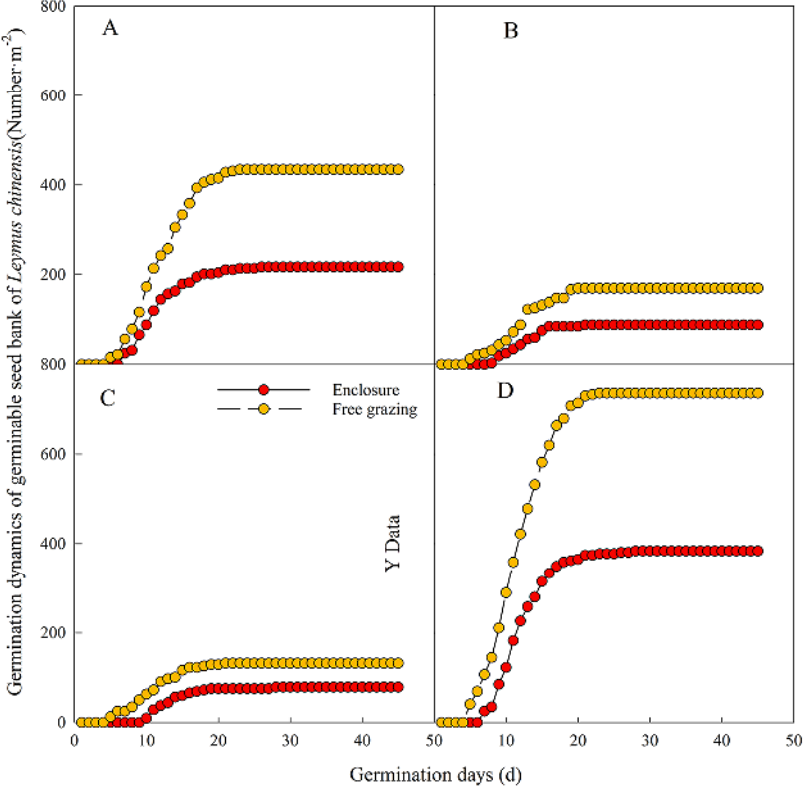
Figure 4. Dynamics of Leymus chinensis seed germination among the free-grazing and enclosed areas in the same soil layer. Note: Figures ( A – D ) show the number of Leymus chinensis seed germination at 0 – 2 cm, 2 – 5 cm, 5 – 10 cm, and 0 – 10 cm, respectively. Table 2. Effects of the free-grazing and enclosed areas on the Leymus chinensis germination seed Table 1. General conditions of the different breeding cattle bank characteristics in the same soil layer.